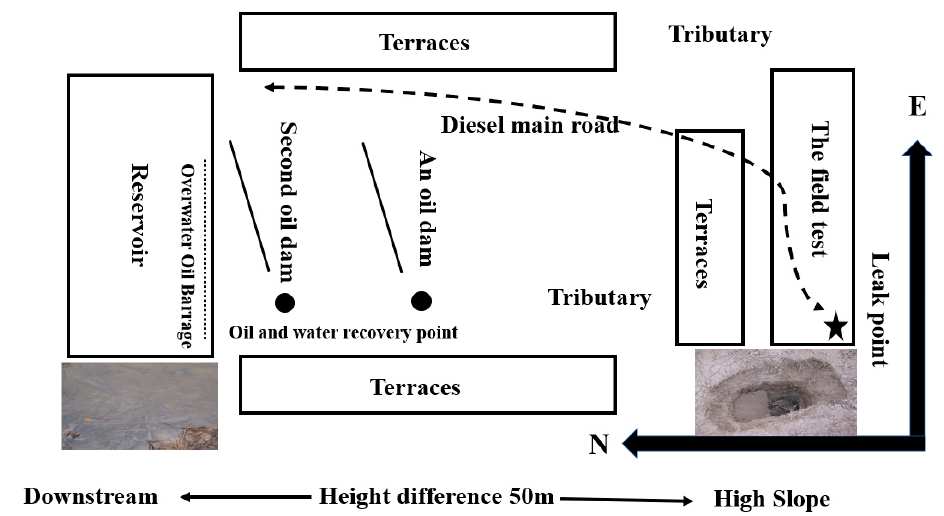
Figure 1. Schematic diagram of contaminated site.